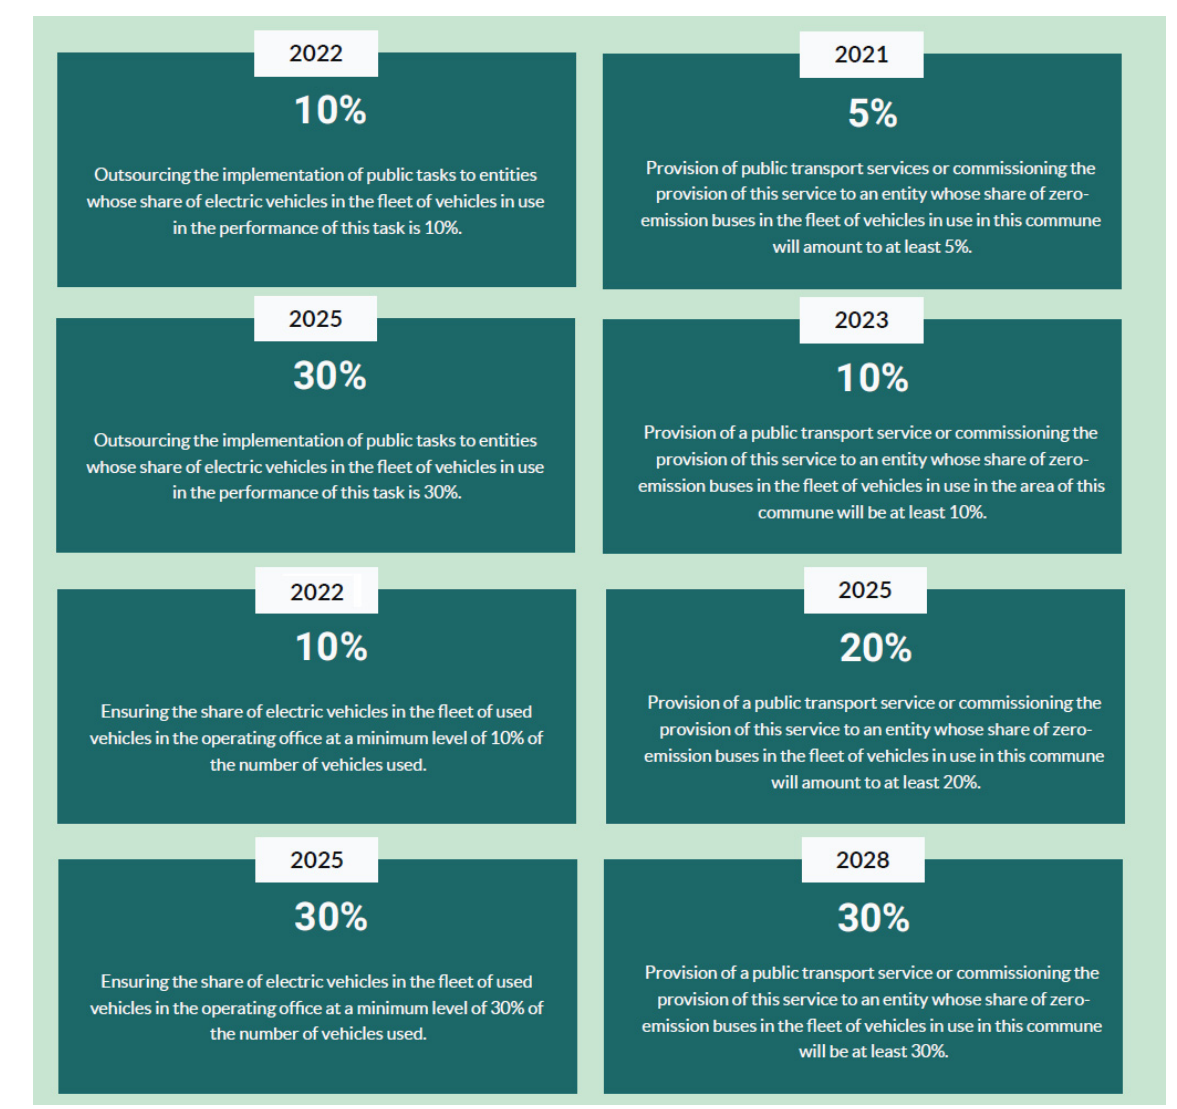
Figure 1. The obligation of entities performing public tasks to use low-emission means of transport in municipalities with more than 50,000 inhabitants.